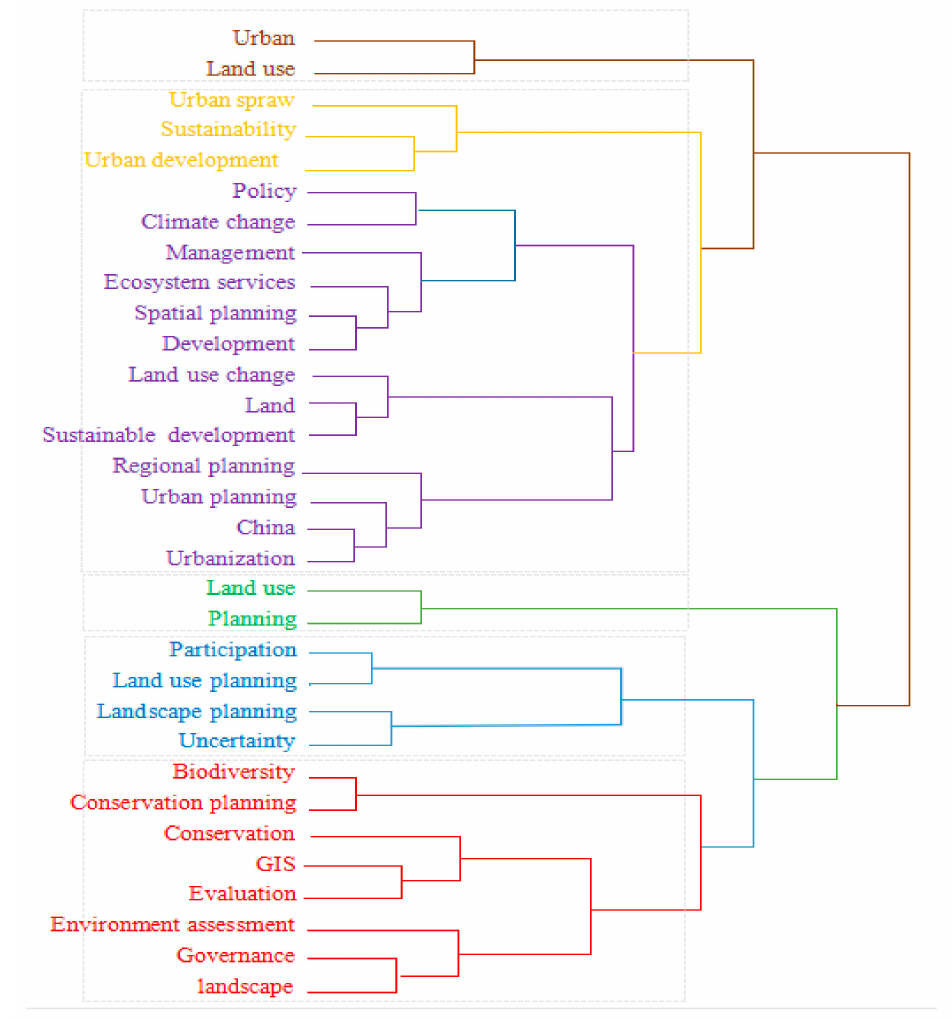
Figure 10. Tree dendrogram of the hierarchical clustering of keywords in land use